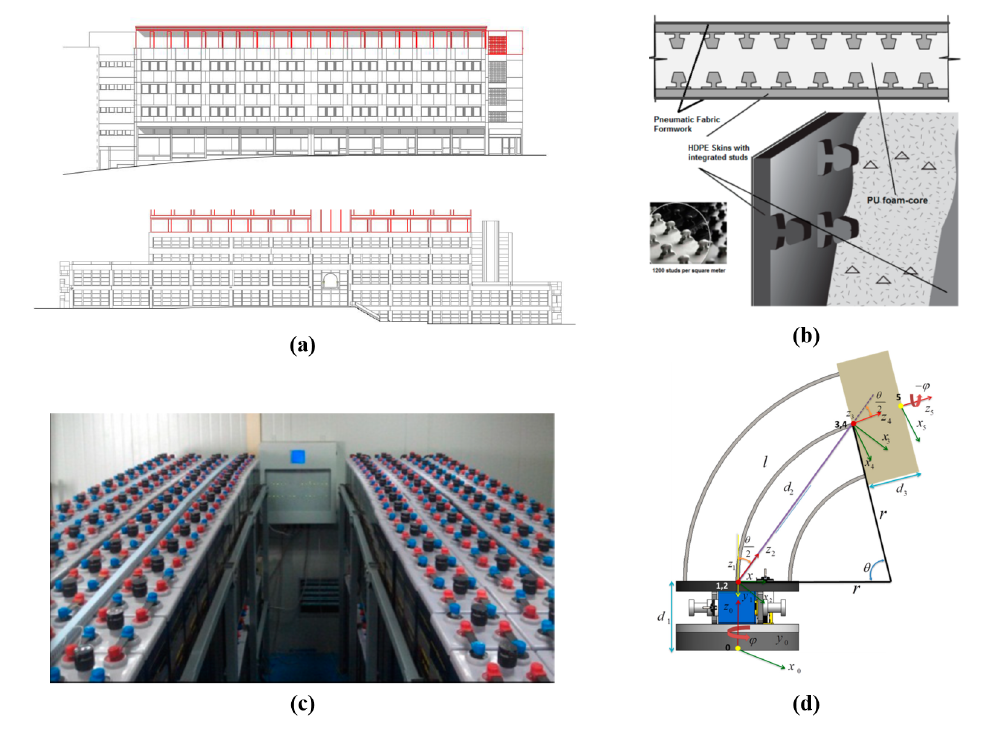
Figure 3. Modular design examples: ( a ) design method to add sections to existing buildings [40]; ( b ) modular panels for emergency housing construction [41]; ( c ) battery storage system in an electric grid [42]; and ( d ) modular mechanical manipulator